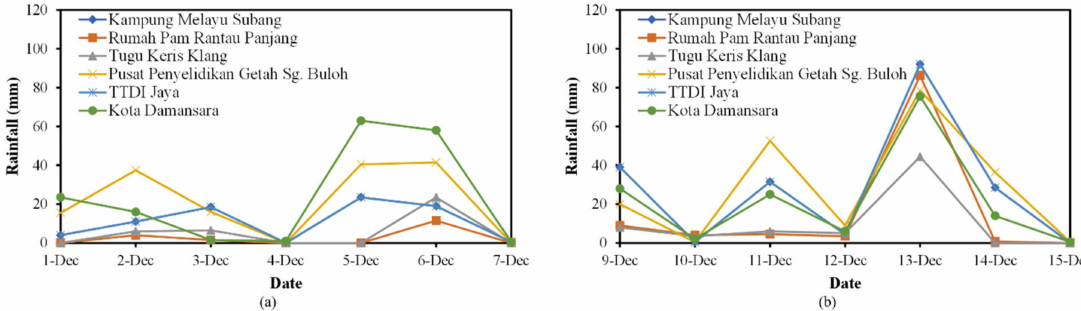
Figure A2. Distribution of daily rainfall of six rainfall stations in Damansara catchment during period ( a ) 1–7 December 2015 (calibration) and ( b ) 9–15 December 2015 (validation).